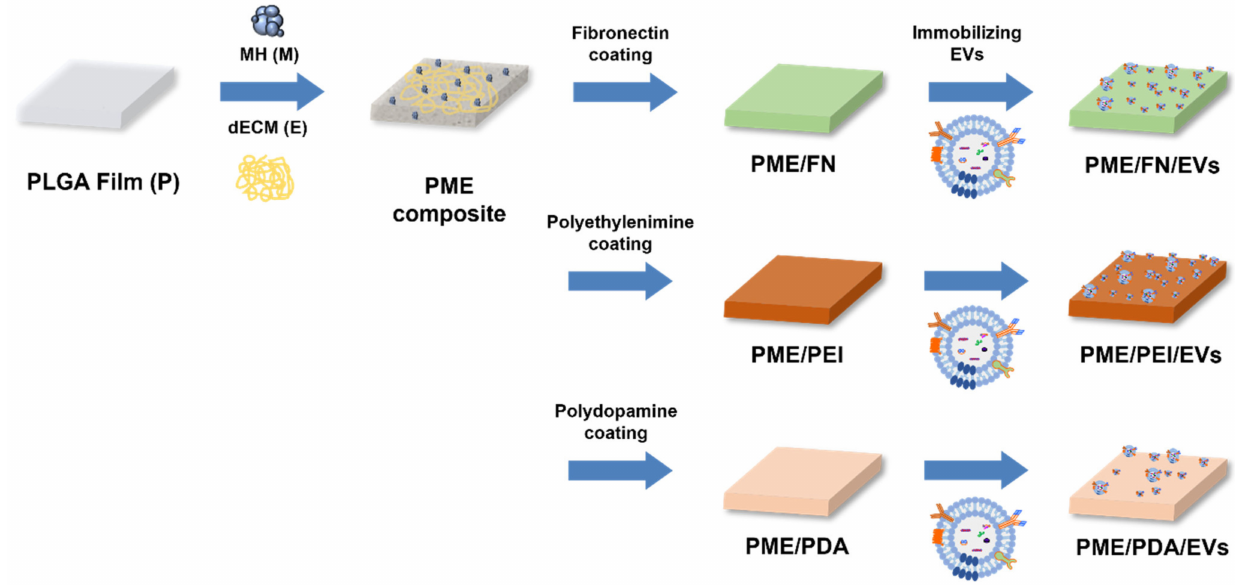
Scheme 1. Comparative analysis of the different surface modification for immobilization of extracellular vesicles (Fibronectin for ligand–receptor interaction; Polyethylenimine for ionic bonding; Polydopamine for covalent